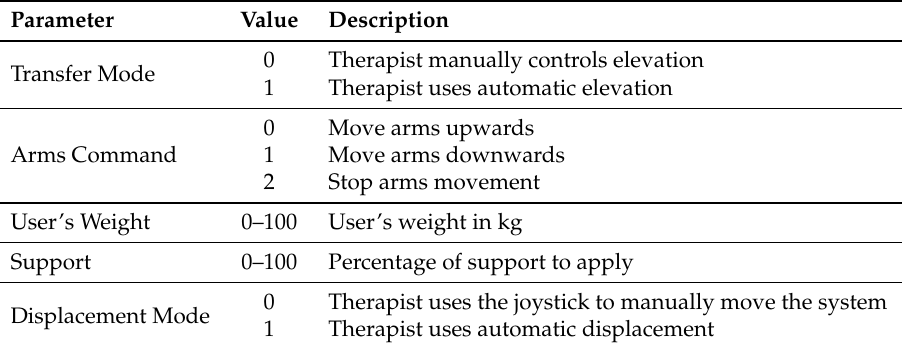
Table 6. H1 to REMOVI data frame.